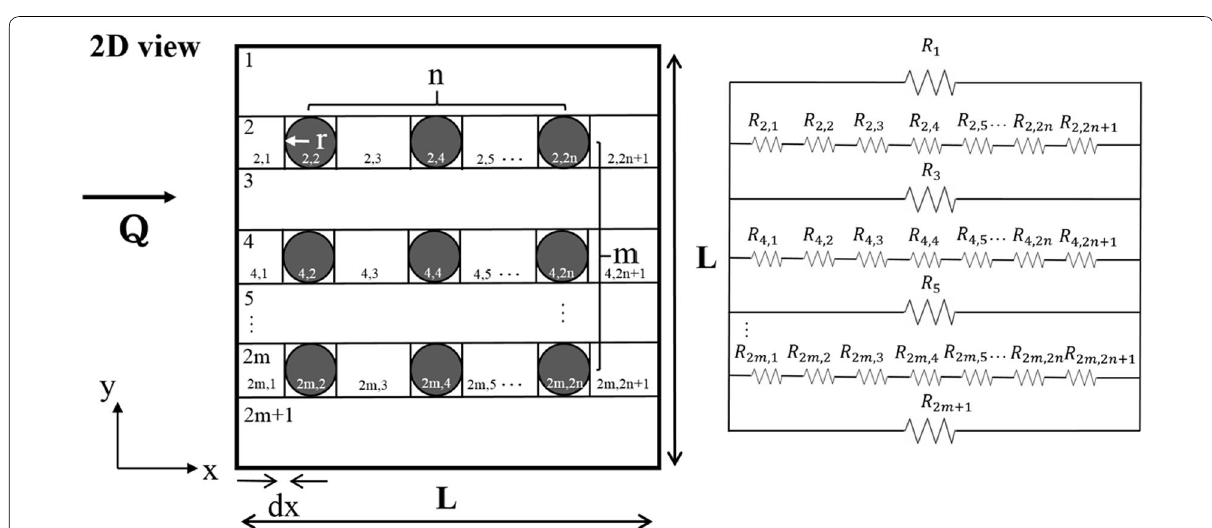
Fig. 4 2-dimensional view of reinforced concrete containing multiple round rebars and its thermal